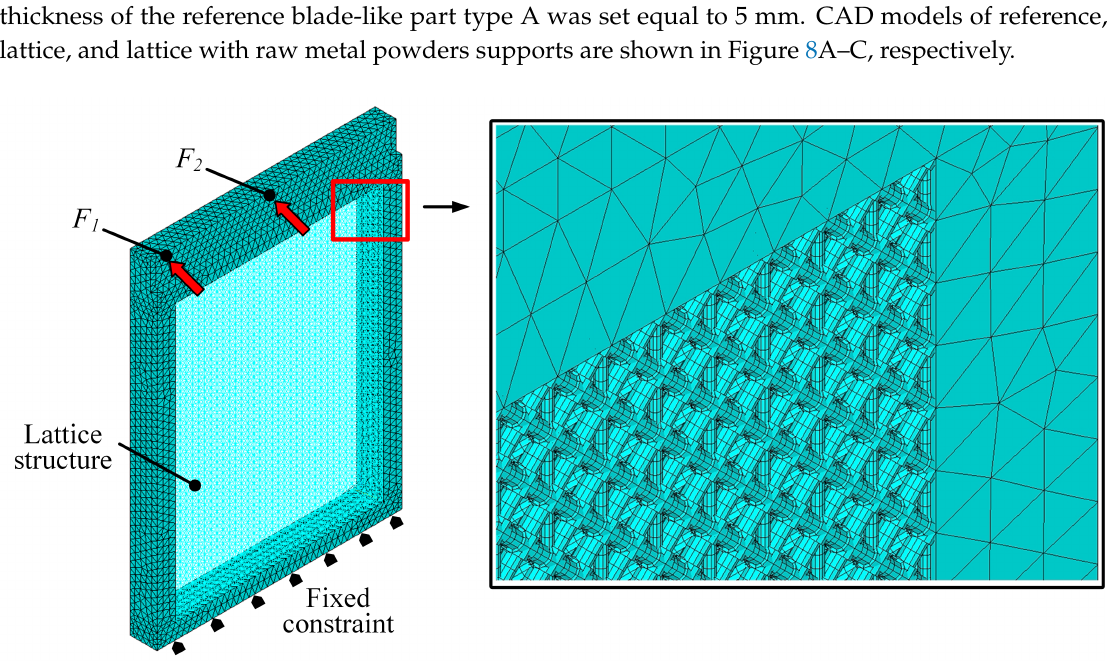
Figure 8A. Optimal contact between workpiece and blade-like support was assured by finishing the contact